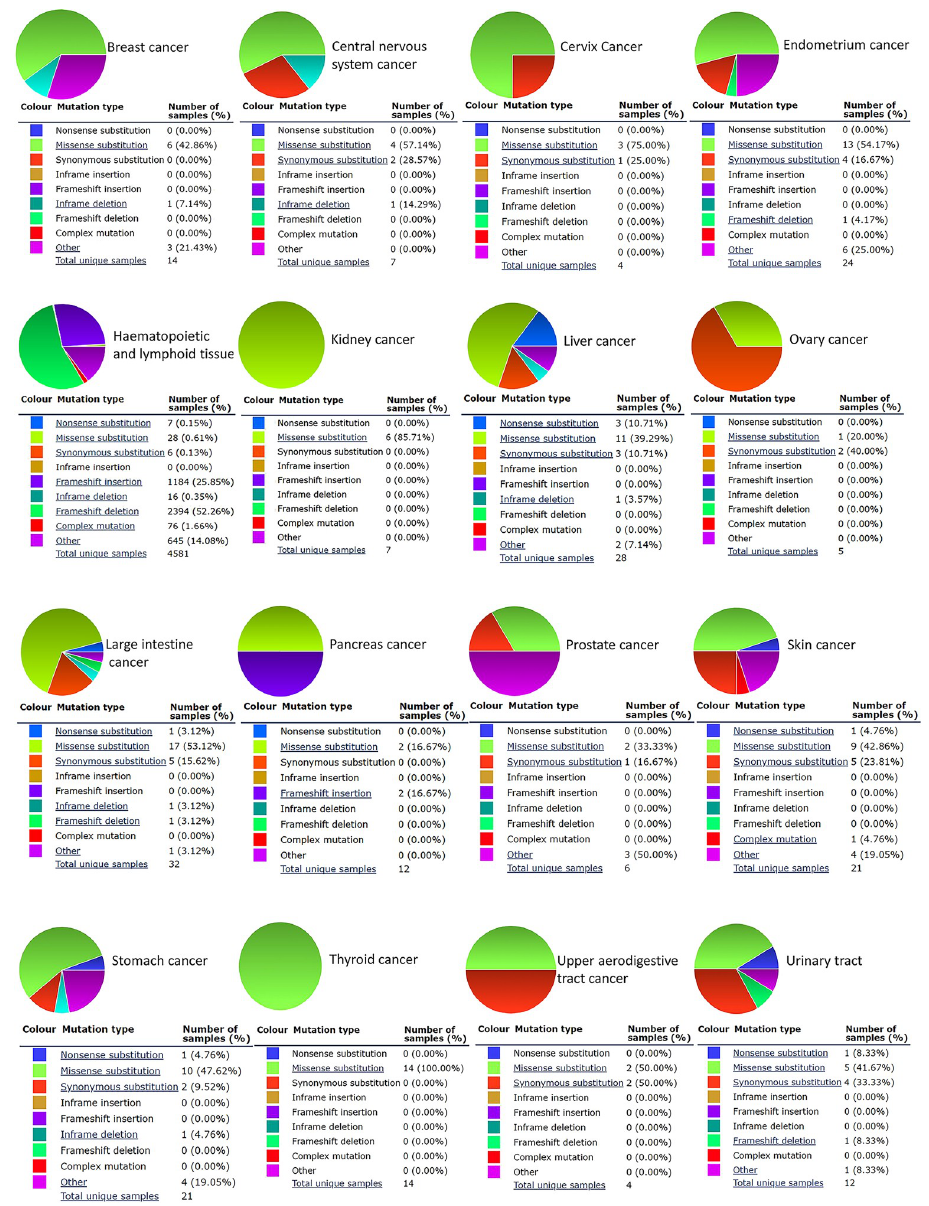
Fig 5. Pie chart showing the percentage of different CALR mutation types in tumors (COSMIC).